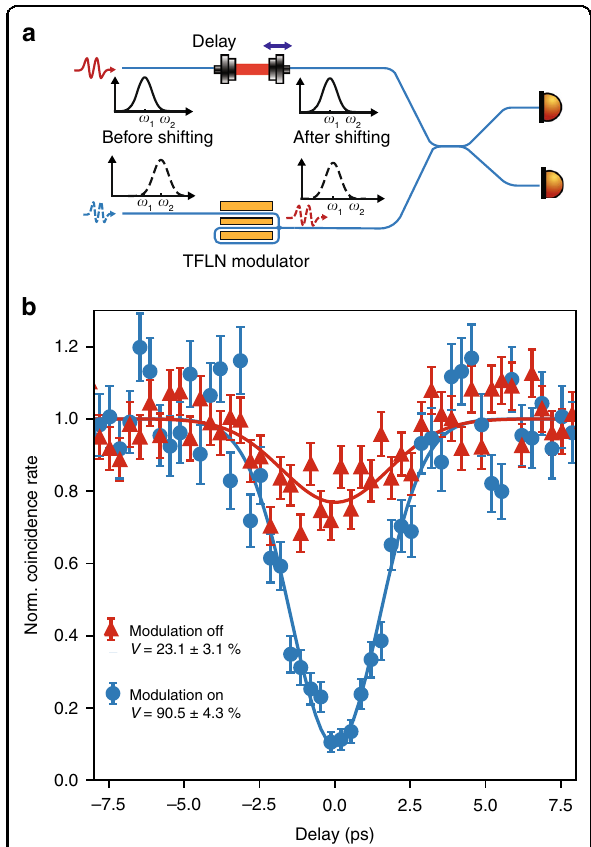
Fig. 4 Hong-Ou-Mandel (HOM) interference between two photons with different frequencies. a HOM interference set-up. The two input photons have FWHM bandwidth of 200 GHz and frequency difference of 154 GHz. The TFLN modulator was used to redshift the blue-detuned photon and erase the spectral distinguishability. The modulator was driven at 4.0 V π with a 13.6 GHz sinusoidal RF signal. b Normalized coincidence rates after background subtraction as a function of path length delay. When the shearing was turned on, the interference visibility increased from 23.1 ± 3.1% (due to partial spectral overlap) to 90.5 ± 4.3%. Error bars indicate one standard deviation assuming Poisson counting statistics. Solid lines: Gaussian fi